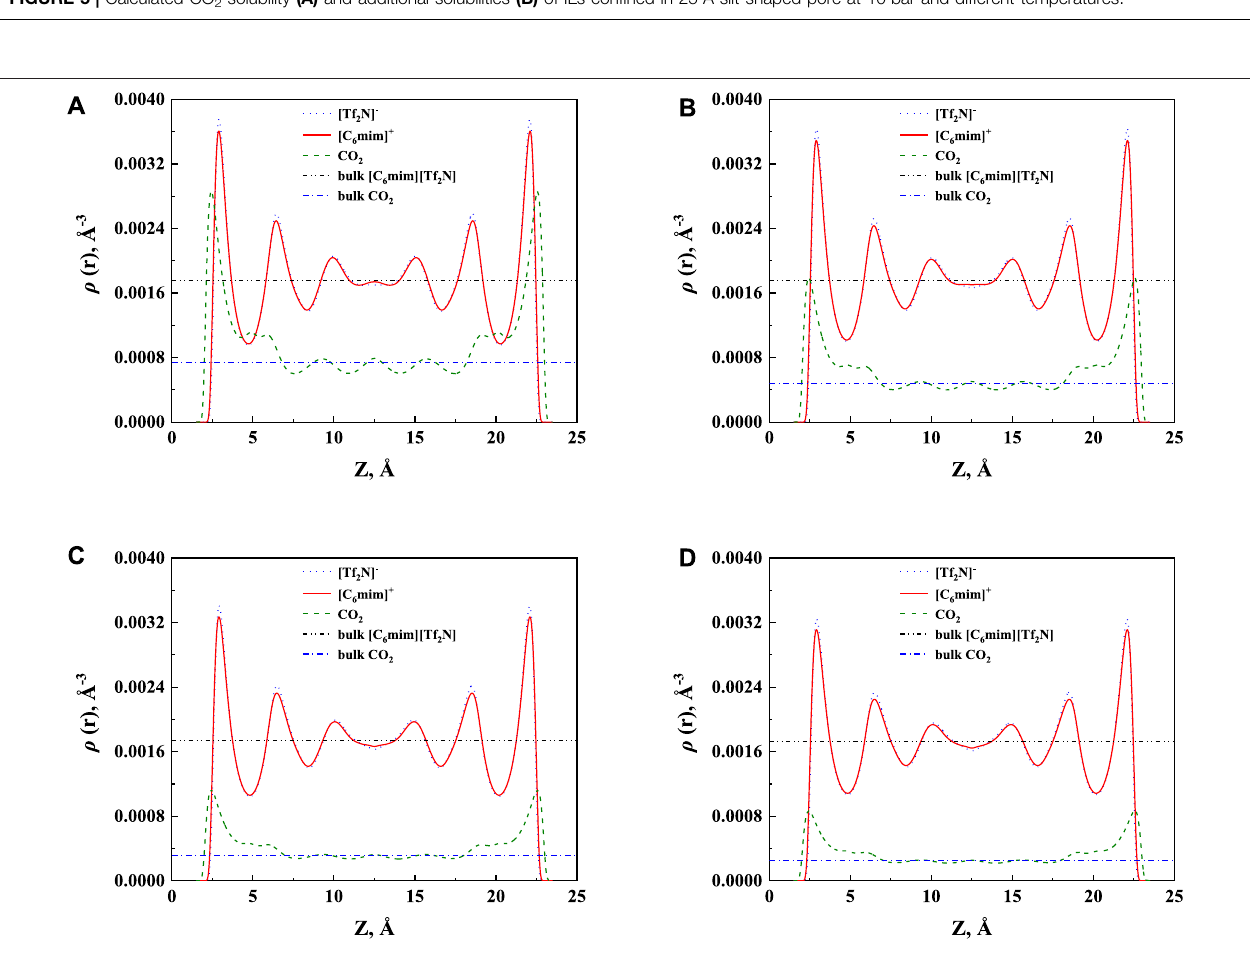
FIGURE 6 | The calculated density pro fi les of [C 6 mim] [Tf 2 N]-CO 2 con fi ned in 25 Å slit silica pore at 10 bar and (A) 298.15 K, (B) 323.15 K, (C) 353.15 K, and (D) 373.15 K.